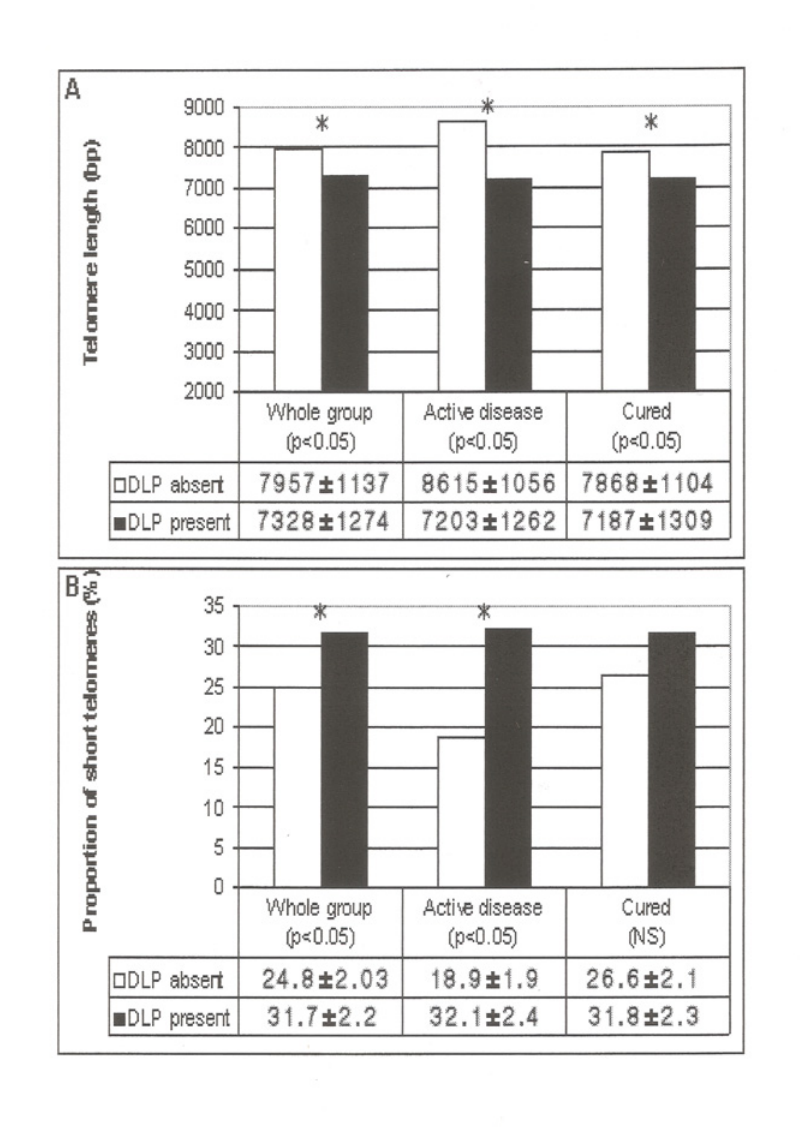
Fig 3. Mean telomere length (A) and proportion of short telomeres ( < 5kb) (B) in patients with Cushing ’ s syndrome according to the presence or absence of dyslipidemia ( * p < 0.05). Abbreviations: bp base pairs; DLP